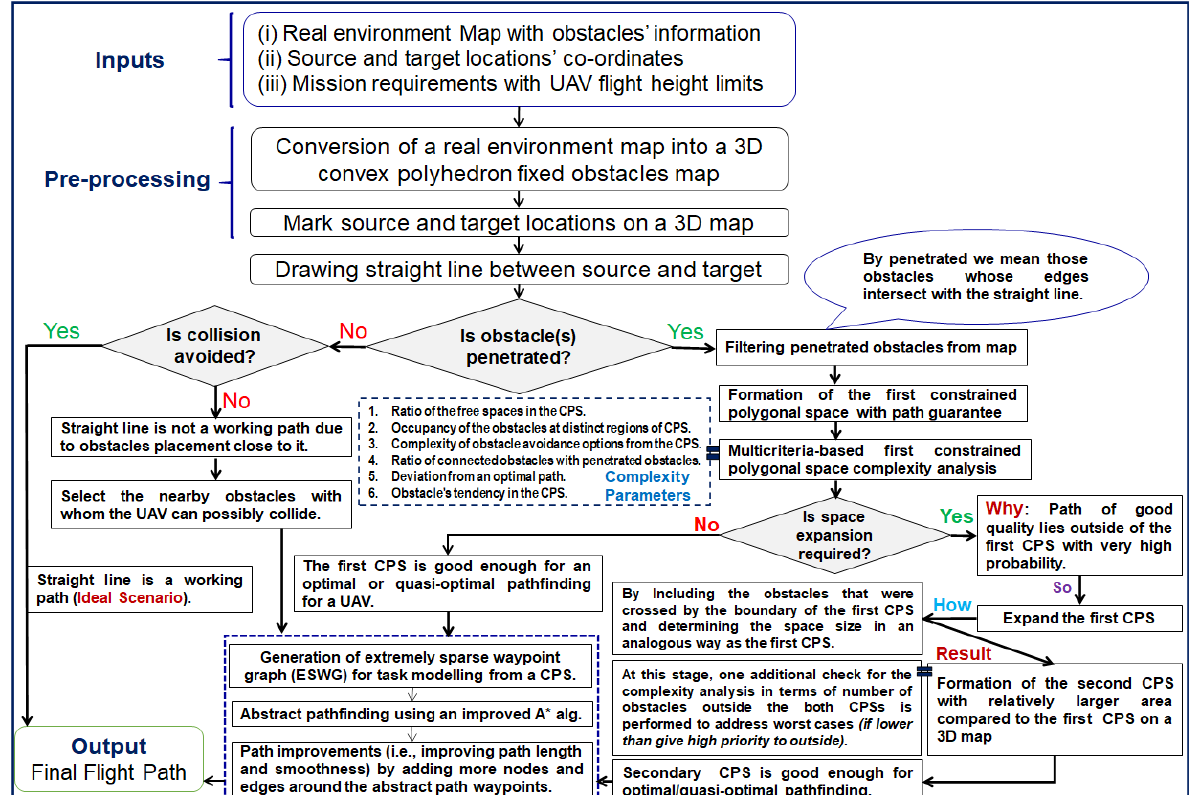
Figure 1. The proposed PP method’s conceptual